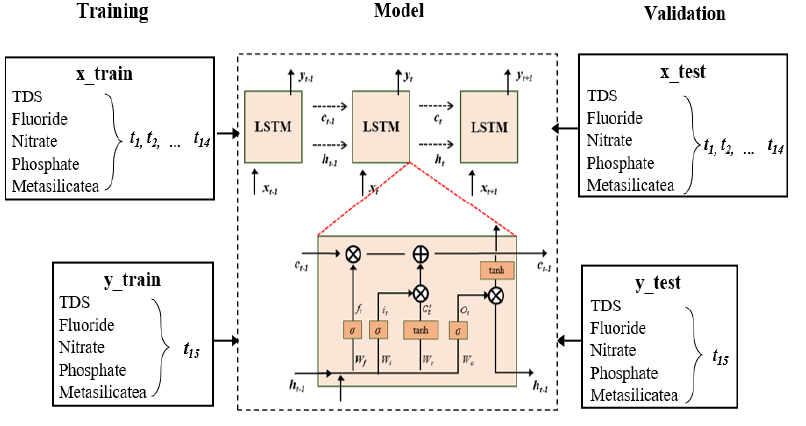
Figure 2. LSTM model